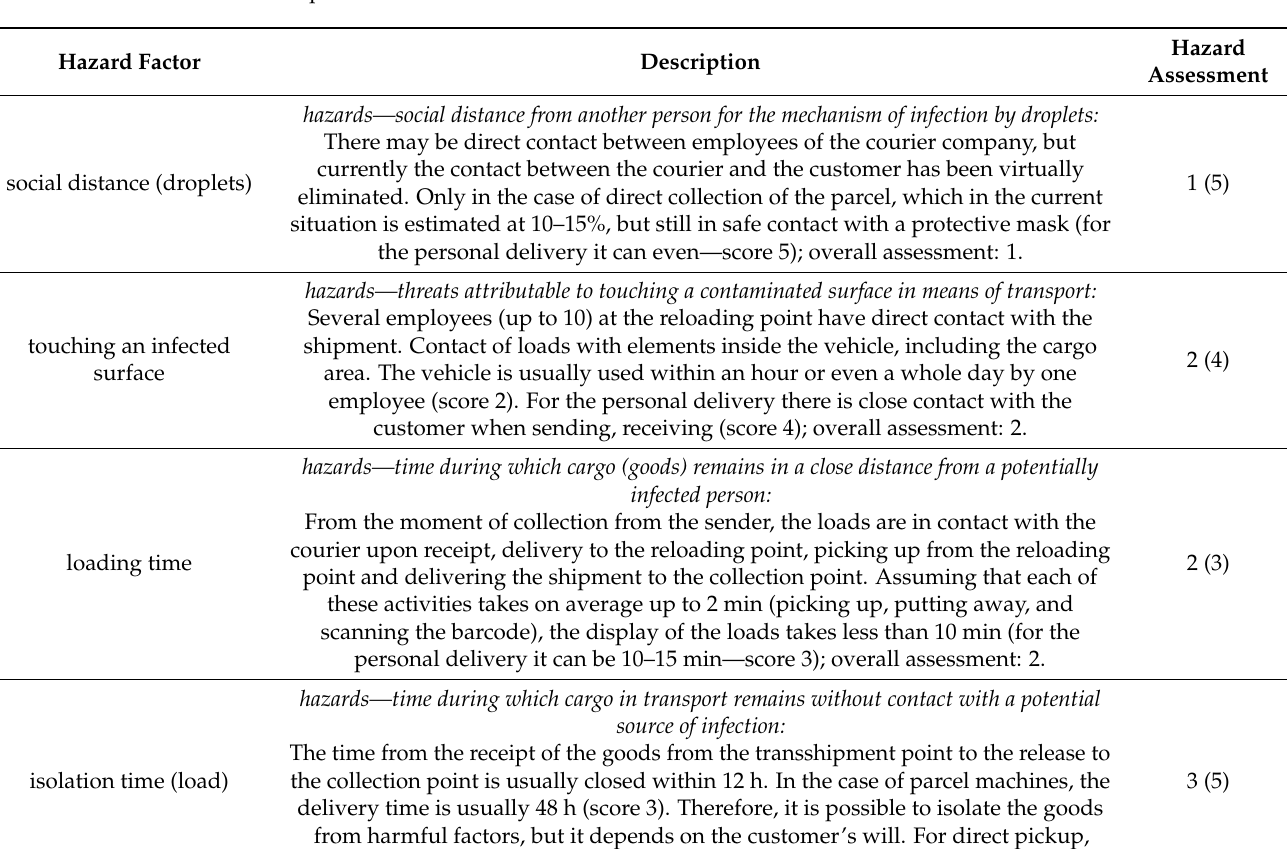
Table 4. Assessment of epidemic hazards due to criteria of the DHI methodology—courier and parcel